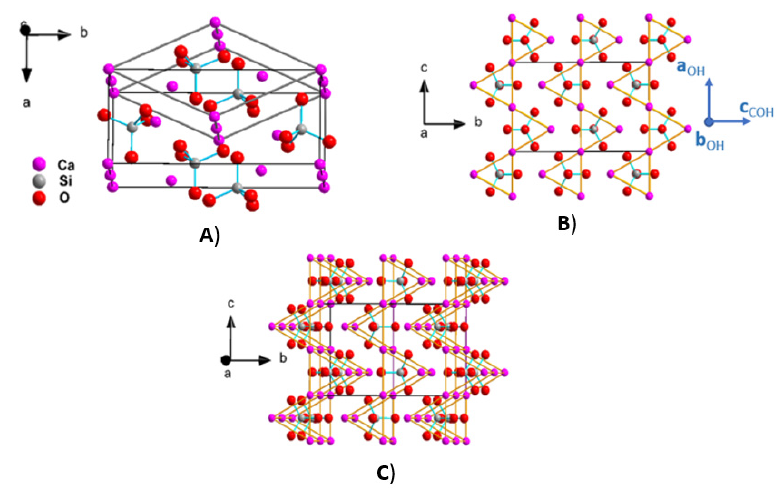
Figure 4. ( A ) The unit cell content of γ -Ca 2 SiO 4 polymorph viewed along c-axis. Light grey lines joining Ca cations indicate the orientation of the hexagonal part of the structure. ( B ) View along the a-axis and the packing arrangement of trigonal prisms is demarcated with orange lines. The relative orientation of the ortho-hexagonal reference system is also indicated. ( C ) Tilted view of ( B ). The Si-O bonds are indicated by cyan lines. Table 2. Unit cell relation of the C23 prototype structure and the unit cells of the five polymorphs of belite with the basic hexagonal unit cell of the 8B2